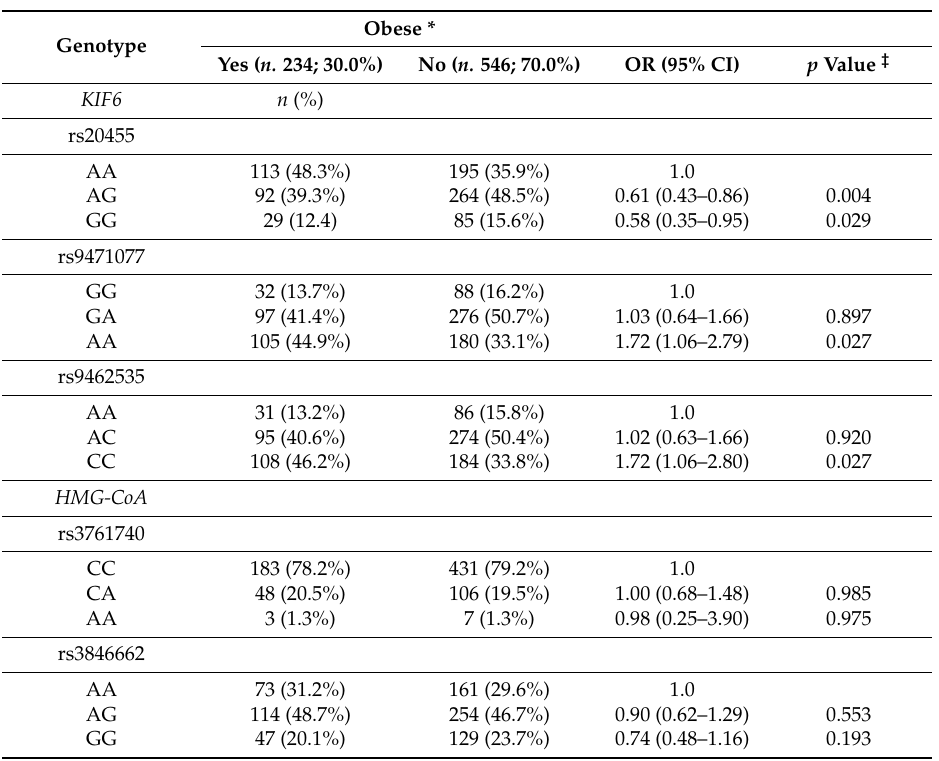
Table 5. Influence of KIF6 and HMG-CoA genotypes † on obesity, calculated according to waist circumference in males.